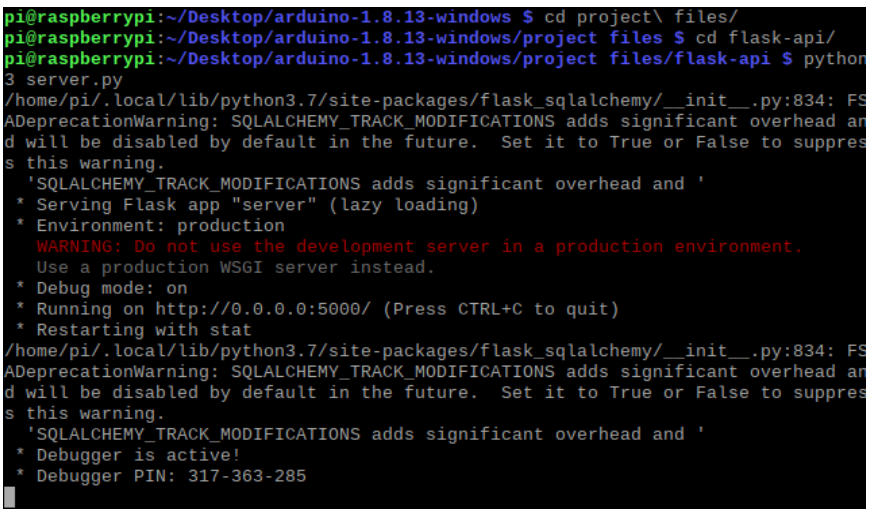
Figure 6. Executing the server.py script on the Raspberry Pi.